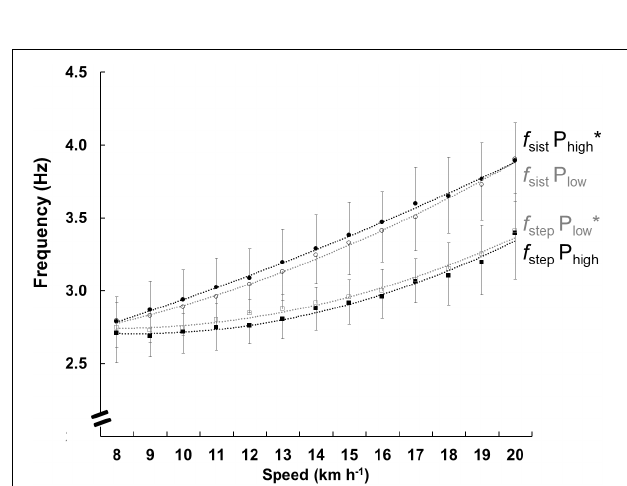
FIGURE 4 | Mean and standard deviation of the frequency parameters at each speed for both groups. The black circles show the natural frequency of the system ( f sist ) in P high and the open circles show P low . The black squares show the step frequency ( f step ) in P high and the open squares show P low . The lines represent the polynomials of the second order function, the black color represents P high , and the gray represents the P low . Its only purpose is to facilitate the viewing of results. The ∗ represents differences between the